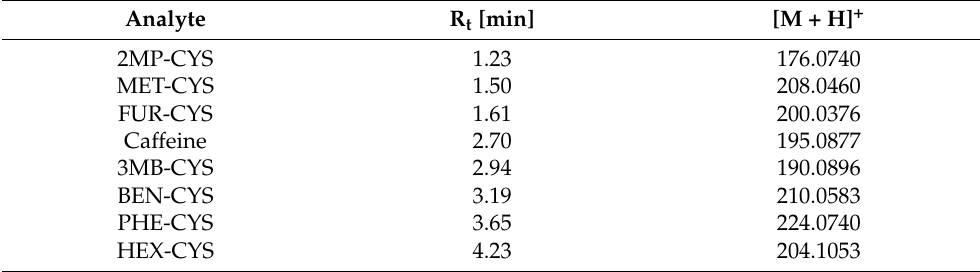
Table 2. Retention times (Rt) and m/z of the molecular ions of the seven cysteinylated aldehydes and